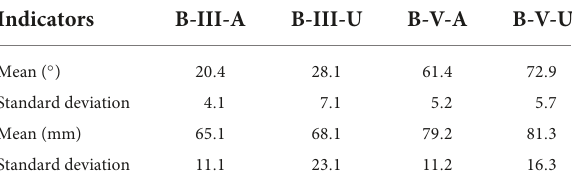
TABLE 5 Statistical analysis of ankle range of motion and the trajectory length of CoP.